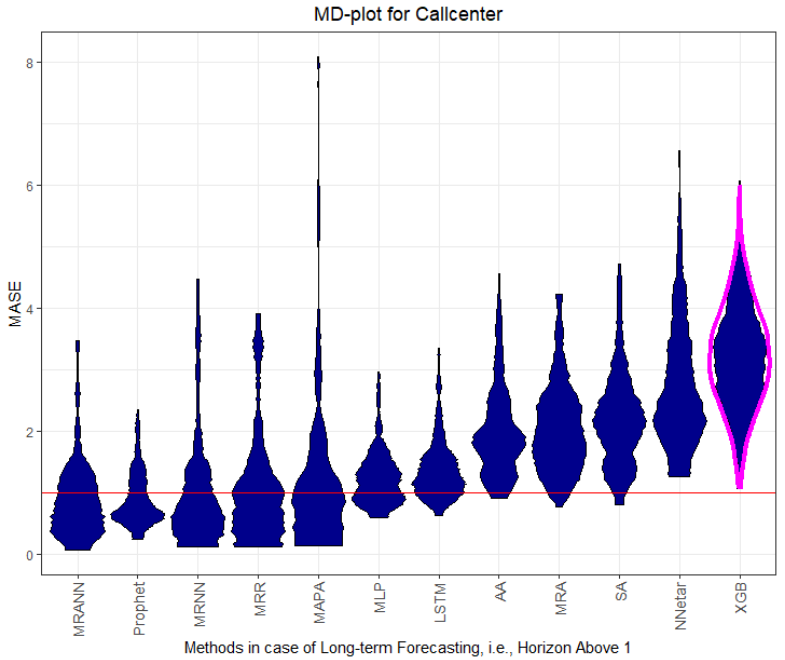
Figure 5. Mirrored density plot of Mean Absolute Scaled Errors (MASE) computed with a rolling forecasting origin over all horizons on dataset Callcenter. The estimated distributions showing a magenta marking are approximately gaussian distributed